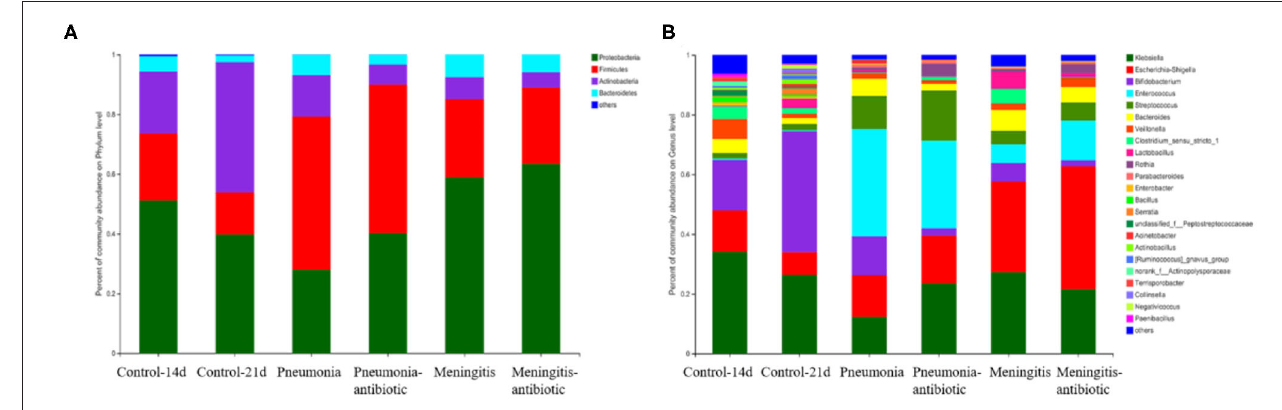
FIGURE 4 | Composition of gut microbiota in phylum (A) and genus (B) level.